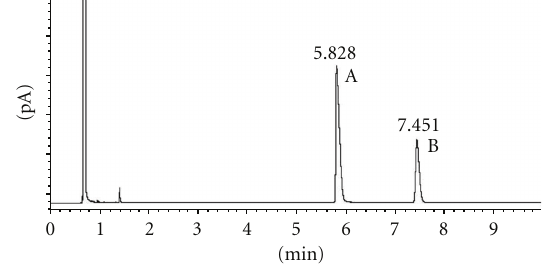
Figure 2: Chiral GC analysis of ( R )-2-heptyl acetate. (A) ( R )-2-